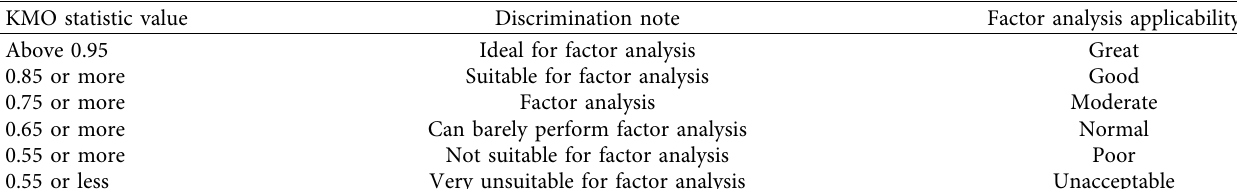
Table 4: KMO judgment criteria.